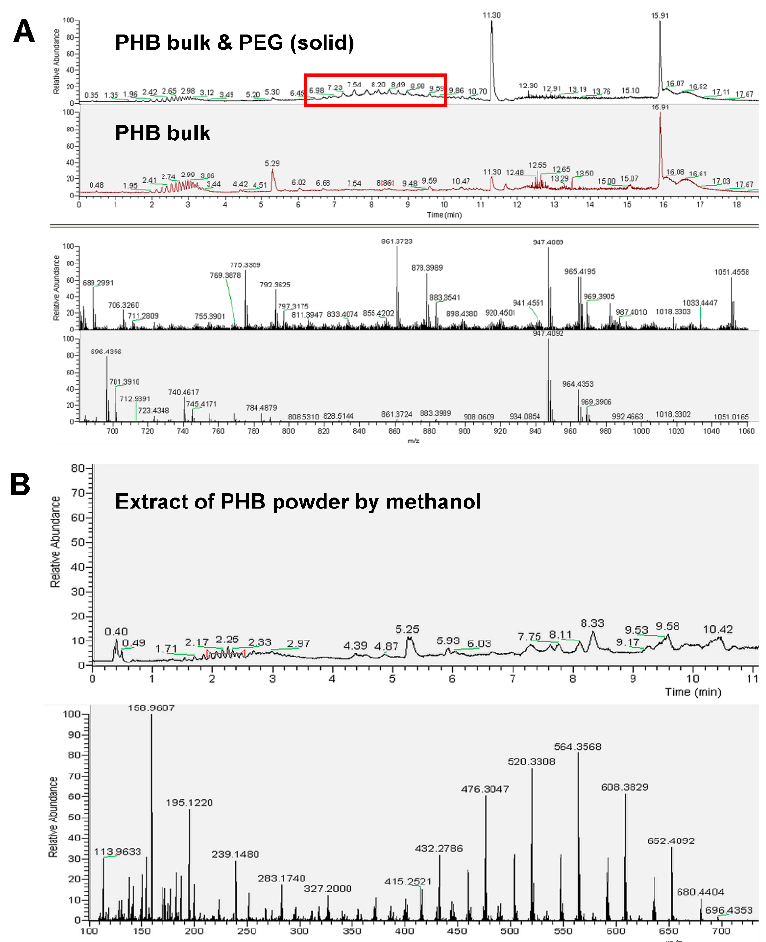
Figure 6. HPLC-MS analysis on hypothesis of dissolution/dispersion of PHB oligomer by PEG. ( A ) Comparison of PHB bulk and the solid part of mixture of PHB bulk and PEG after heat treatment under 150 °C for 4 h. ( B ) Extract of PHB powder with methanol.